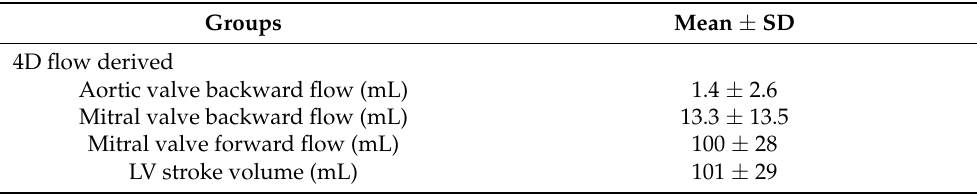
Table 2. Descriptive statistics of recorded